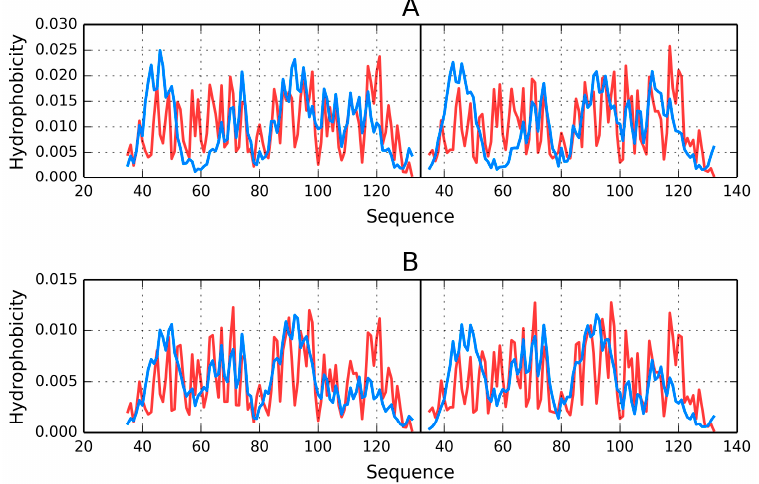
Figure 3. Hydrophobicity density distributions (theoretical: blue line; observed: red line) in 1Y7Q. ( A ) Monomer chain A and B respectively; ( B ) chain A and B in dimmer (common ellipsoid for both chains).